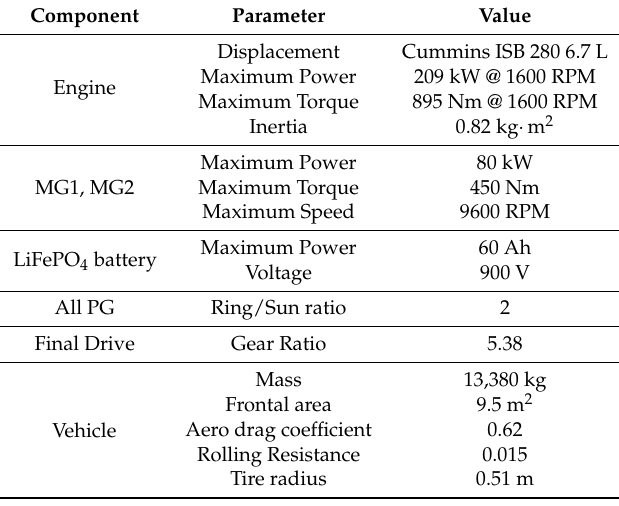
Table 1. Parameters of a Gillig plug-in hybrid electric bus with the Allison Hybrid System (AHS) powertrain [30]. PG: planetary